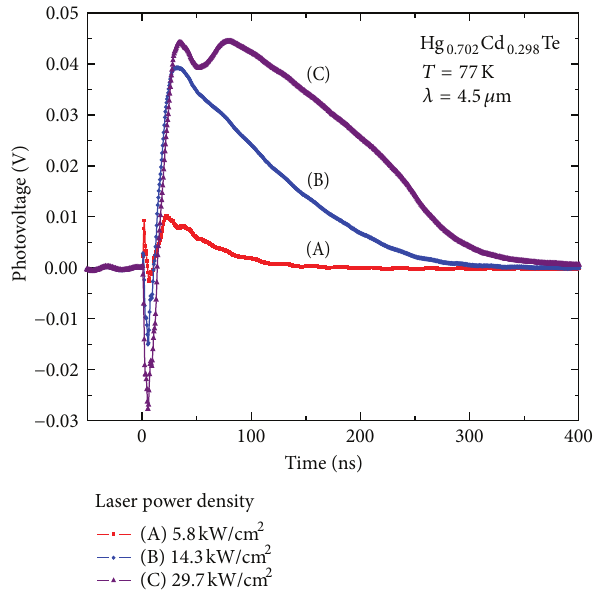
Figure 2: Transient PV response of the detector illuminated by the pulsed laser with the photon energy larger than the bandgap for the different incident